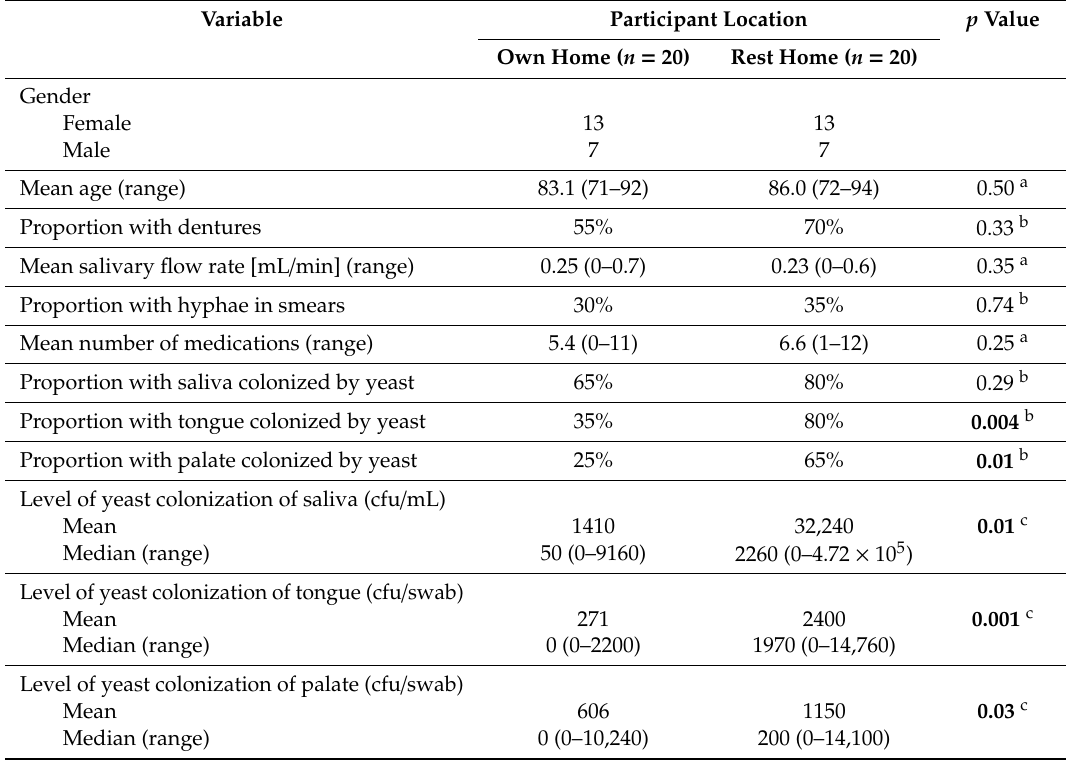
Table 1. The demographics, clinical features, and colonization status of the